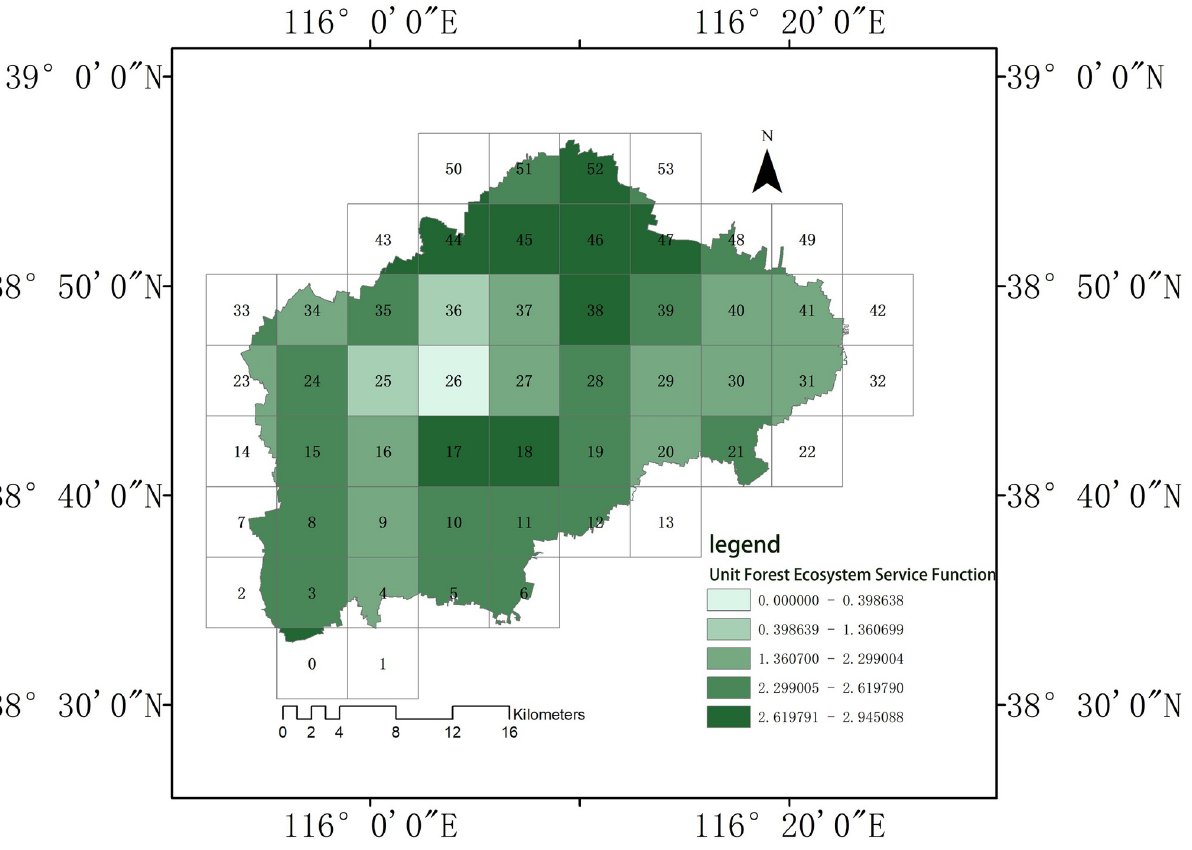
Fig 5. Distribution of forest ecosystem service functions across the study